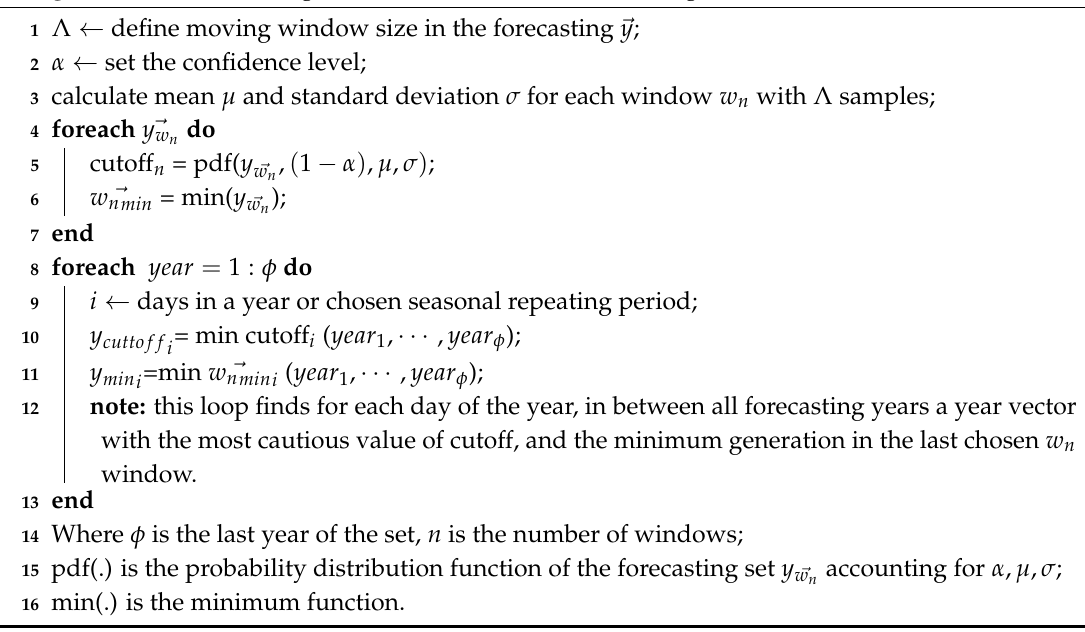
Algorithm 4: Determining confidence areas in the